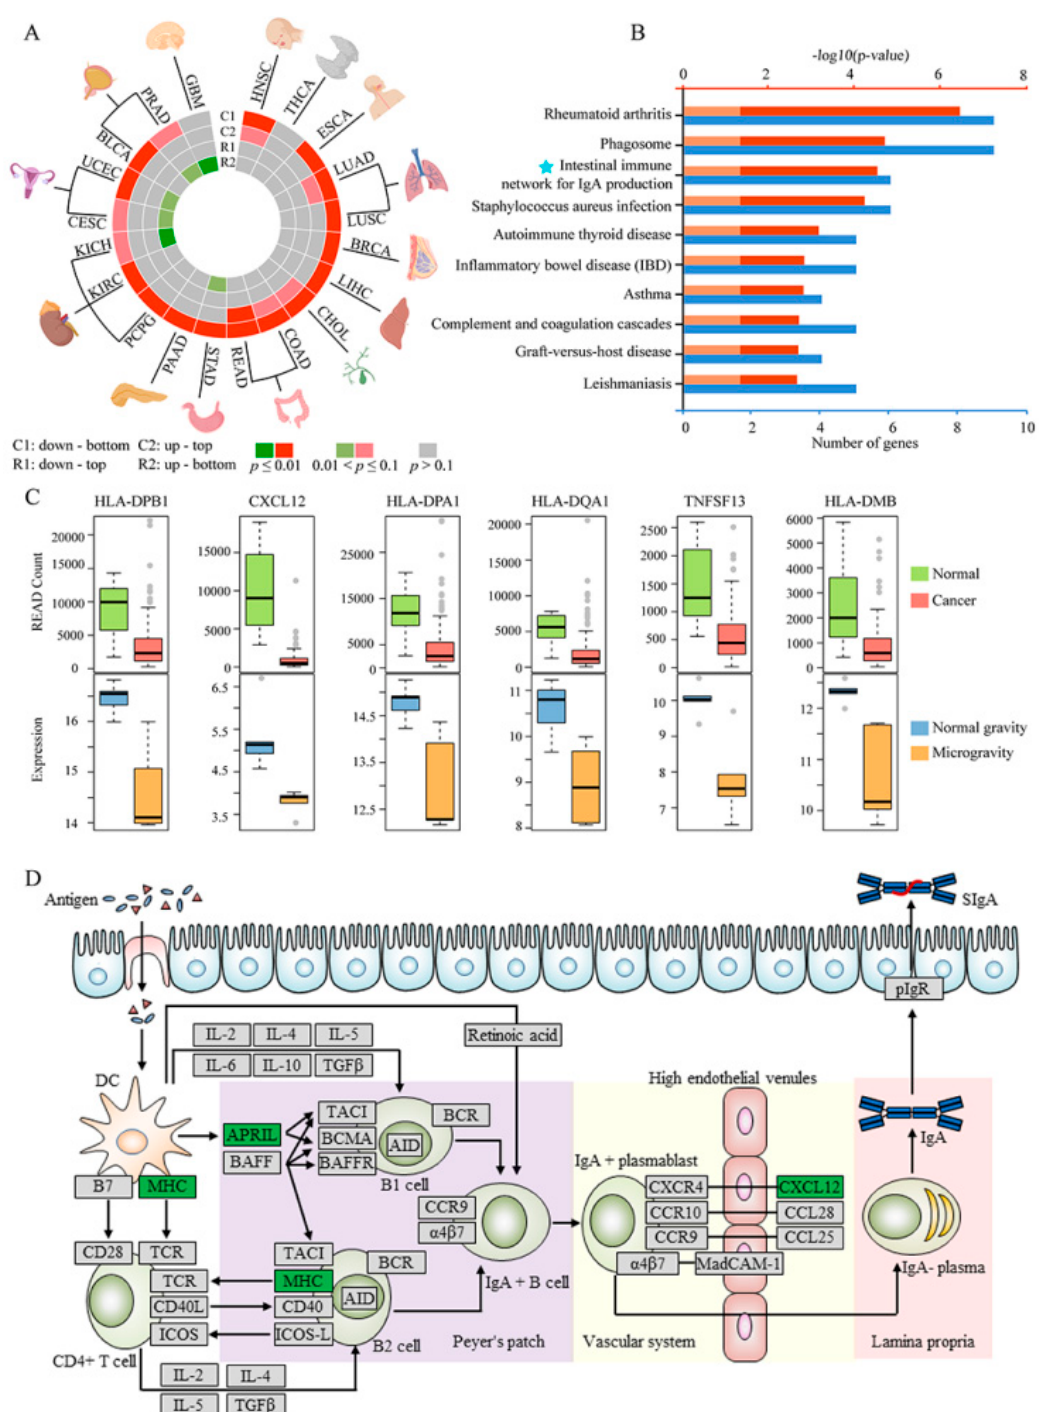
Figure 5. Relationships between microgravity and cancers. ( A ). Wilcoxon rank-sum test results. ( B ). Pathway enrichment analysis for 115 DE genes. The length of blue and red bar represents the number of genes and − log10( p -value), respectively. The pink bar represents p -value = 0.05. ( C ). Boxplots of the expression of six genes ( HLA-DPA1 , HLA-DQA1 , HLA-DPB1 , HLA-DMB , CXCL12 and TNFSF13 ) in rectum adenocarcinoma (READ) samples and microgravity samples. ( D ). Intestinal immune network for IgA production pathway. The green box represents the downregulated gene enriched in the pathway.